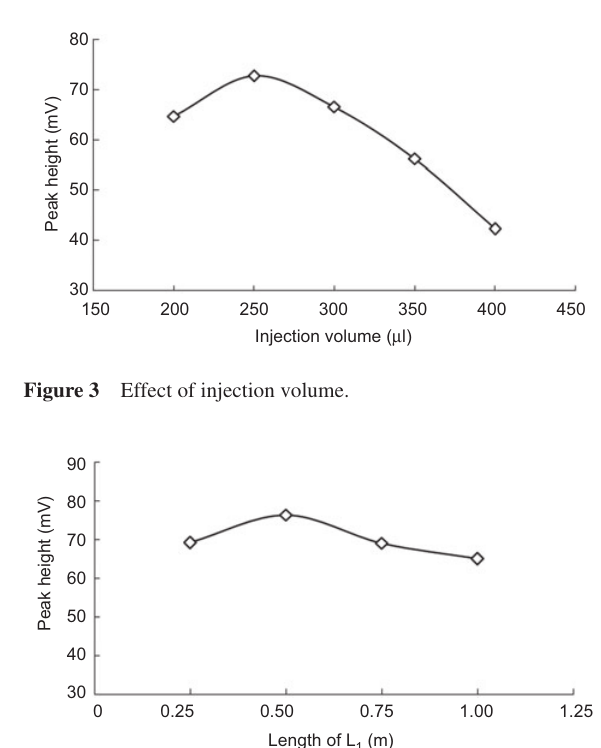
Figure 4 Effect of reaction coil (L